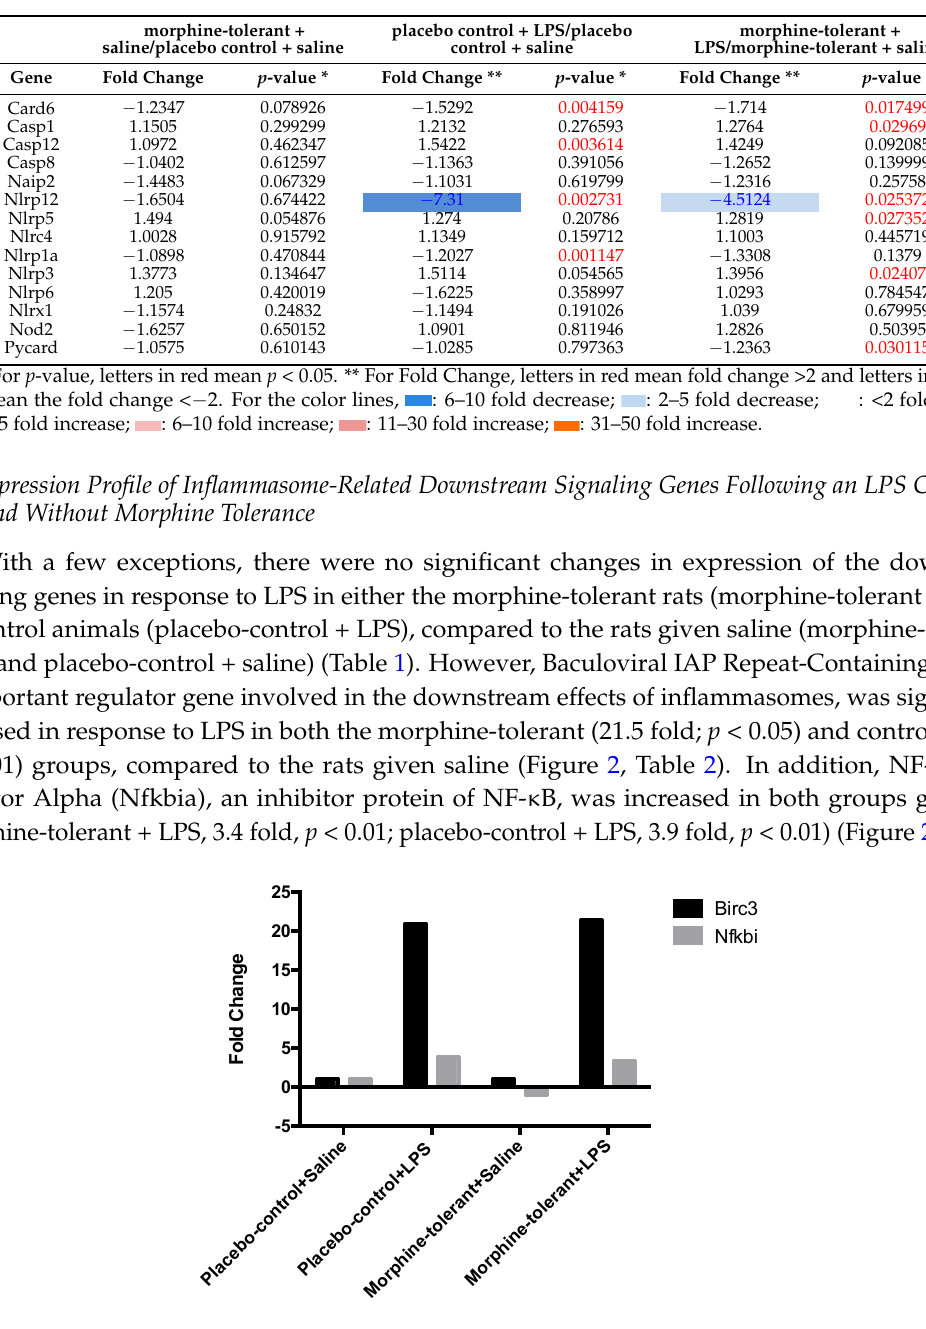
Table 1. Expression profile of inflammasomes and NLR genes in the rat brain in response to lipopolysaccharides (LPS), with and without morphine tolerance.